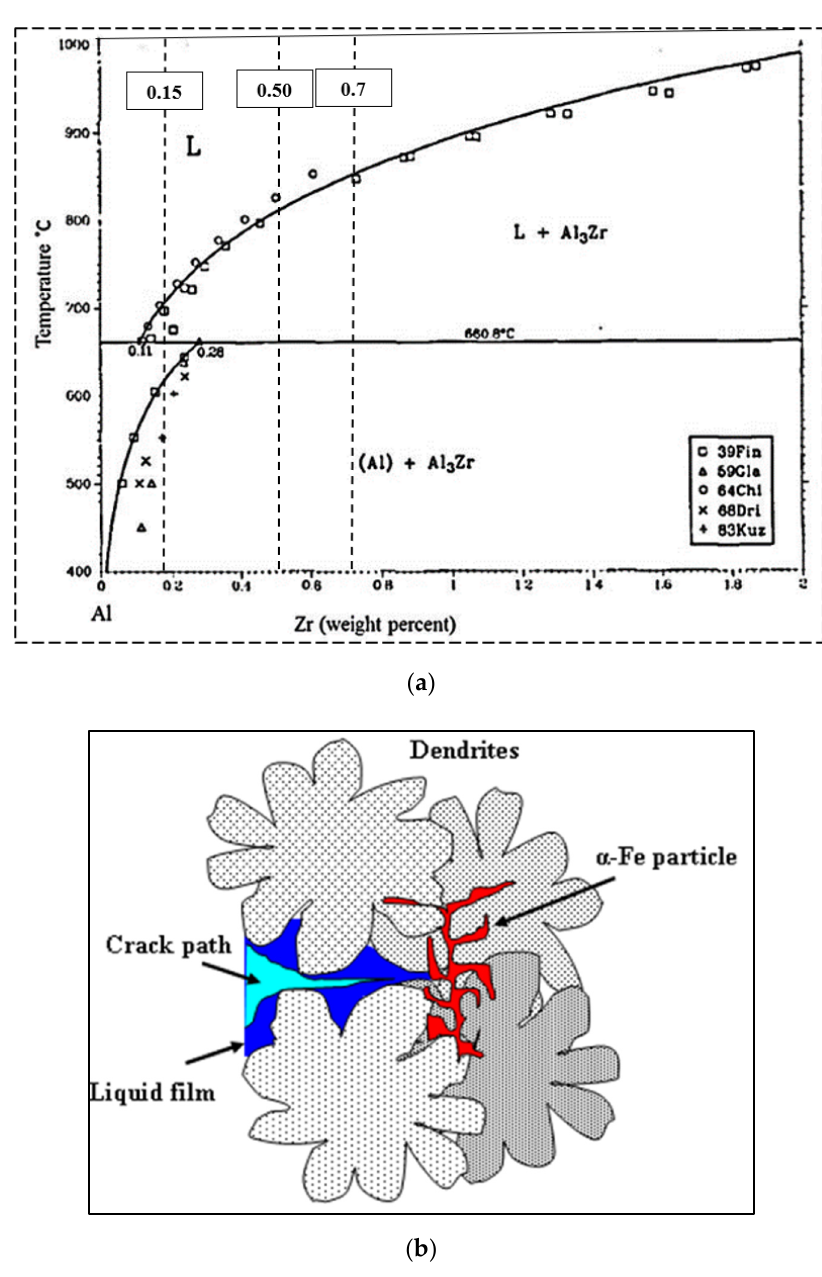
Figure 1. ( a ) Al-rich corner of the Al-Zr binary phase diagram (adapted from [18]). ( b ) Schematic sketch showing how α -Fe particles obstruct crack propagation in the alloy.